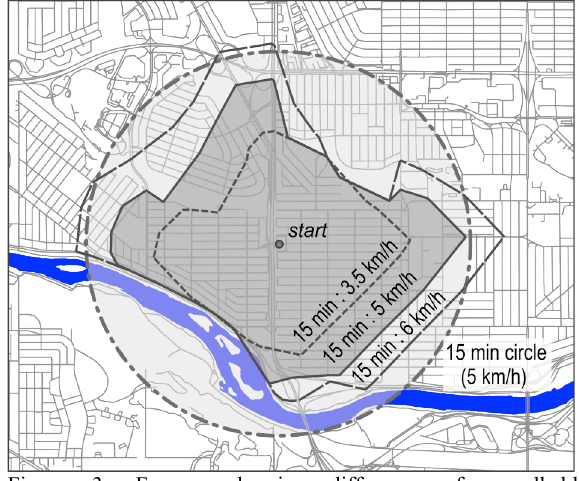
Form and size differences for